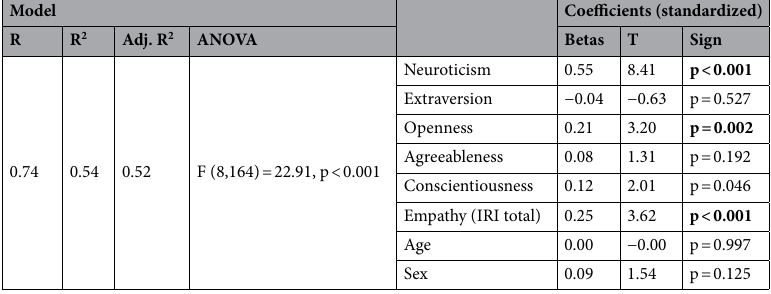
Table 2. Regression analyses of SPS with personality measures as predictors. Significant values in bold.